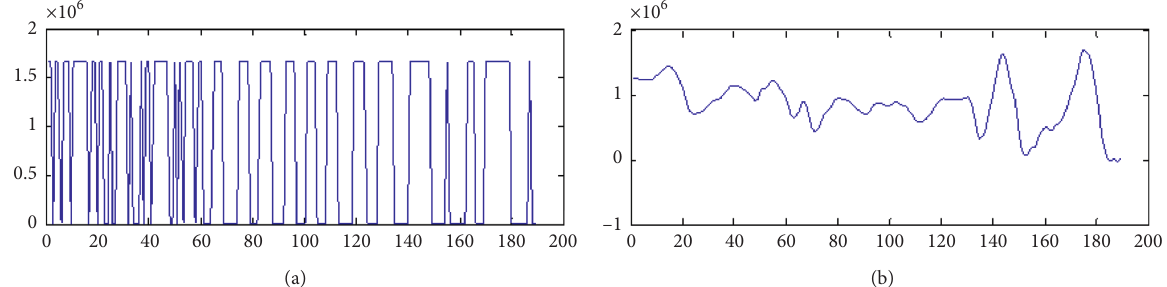
Figure 3: Wavelet noise reduction map (the upper and lower are the original signal and the signal is processed using a layered